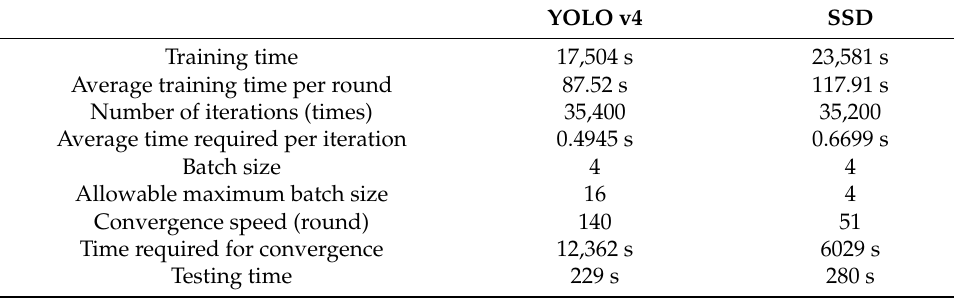
Table 4. Comparison table of target detection model performance.